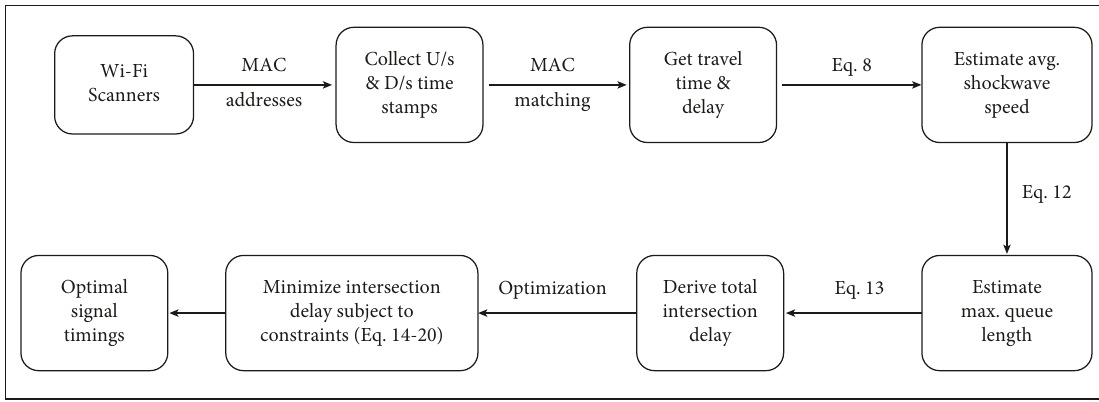
Figure 2: Flowchart of